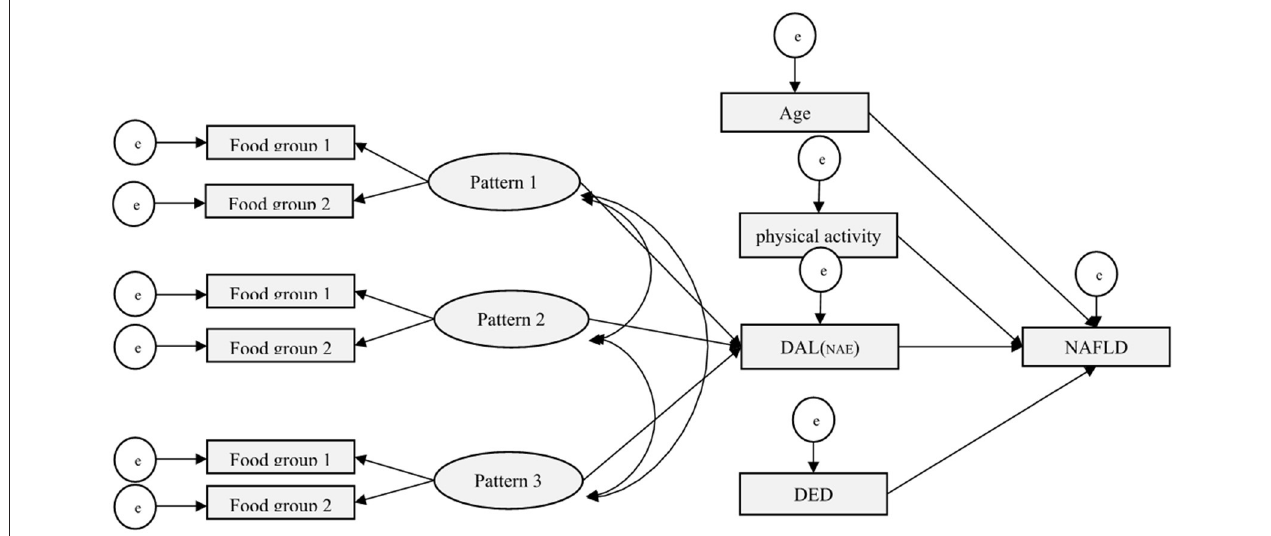
FIGURE 3 | Conceptual SEM model for the association of demographic-behaviors factors, dietary patterns, and DAL with NAFLD.